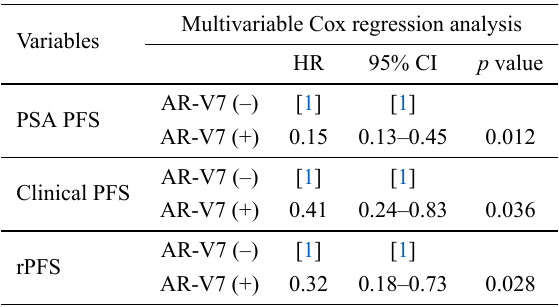
Table 5. Multivariable Cox regression analysis of time-to-event outcomes in AR-V7 positive patients treated with Abi or